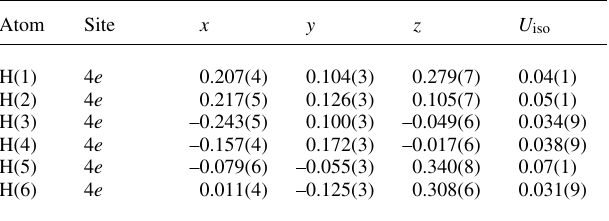
Table 1. Data collection and handling. Table 2. Atomic coordinates and displacement parameters (in Å 2 )